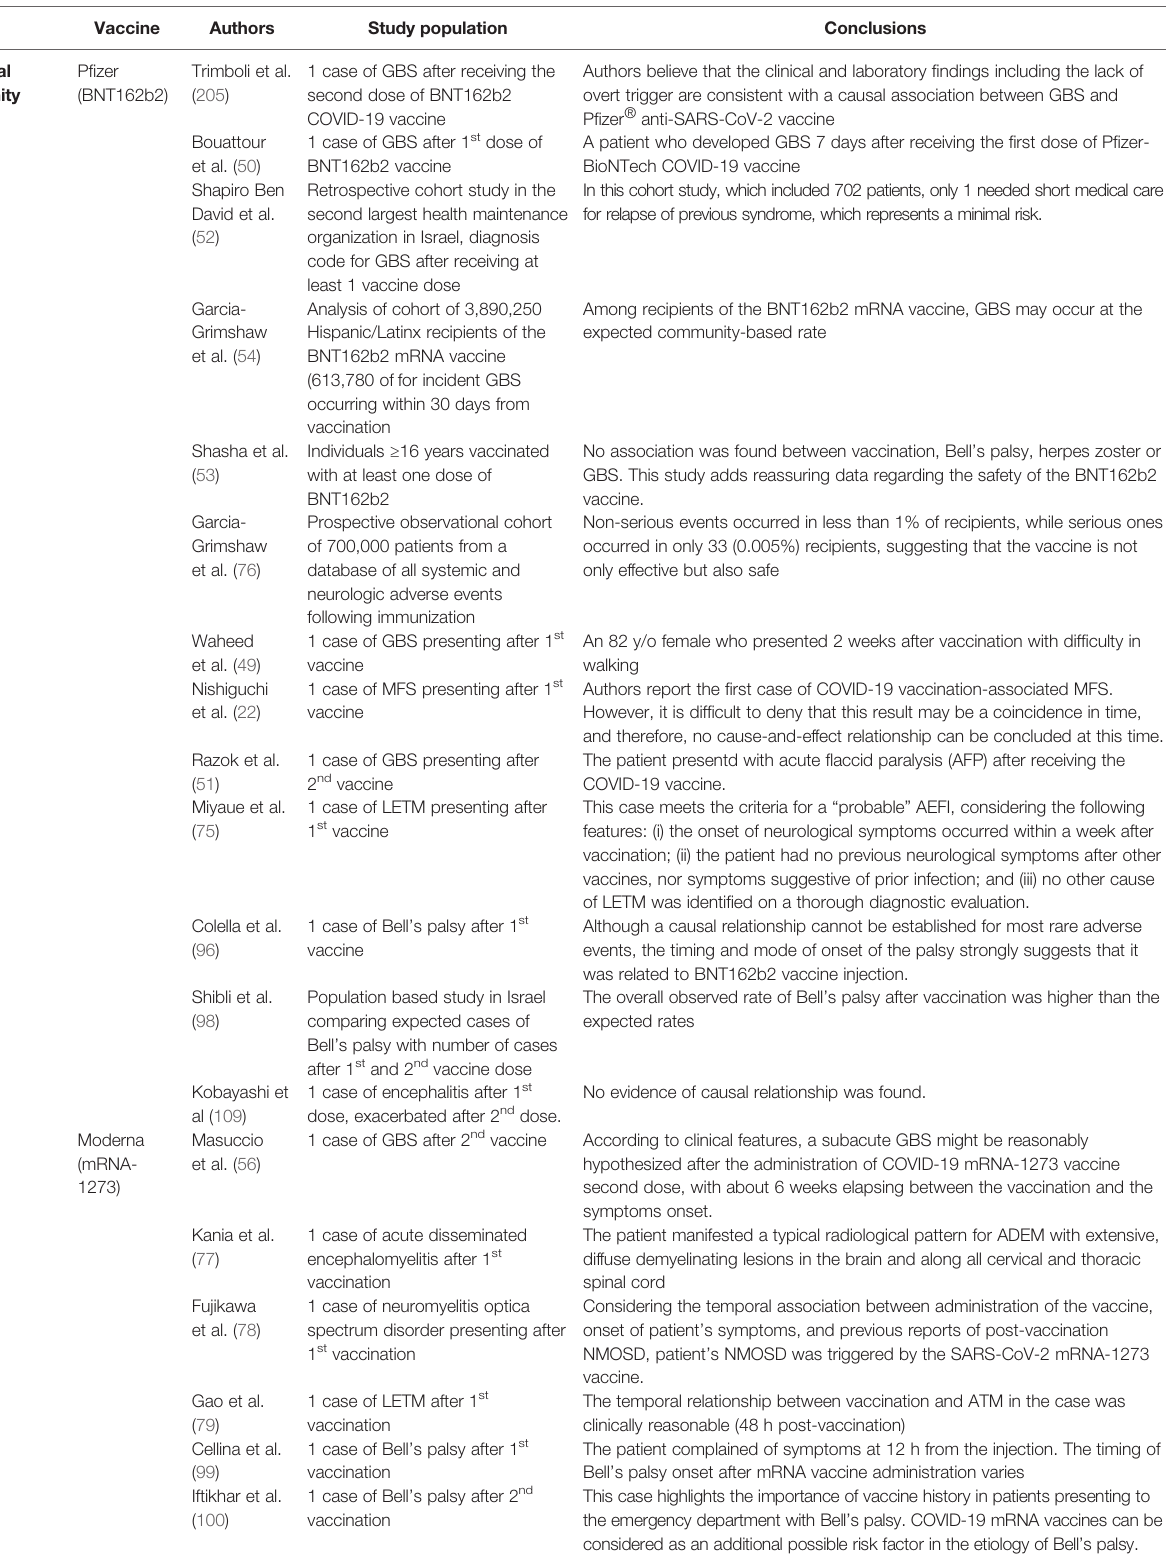
TABLE 1 | A brief summary of studies addressing immune and autoimmune side effects of COVID-19